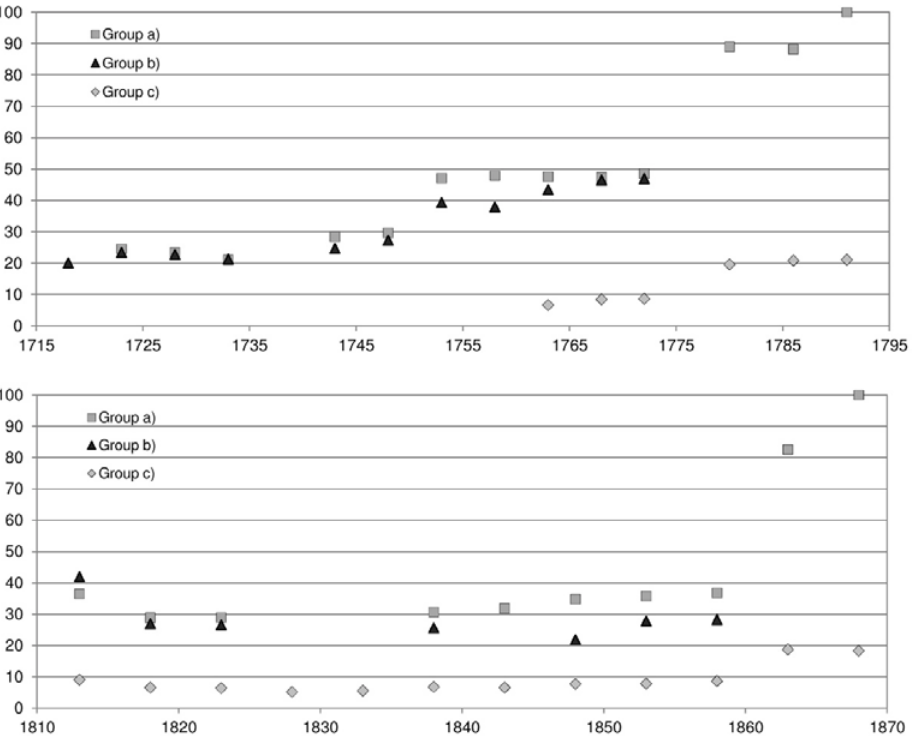
Figure 3. Variations in rent values of the three groups of grazing lands between 1715 and 1850 nor- malised and expessed in silver